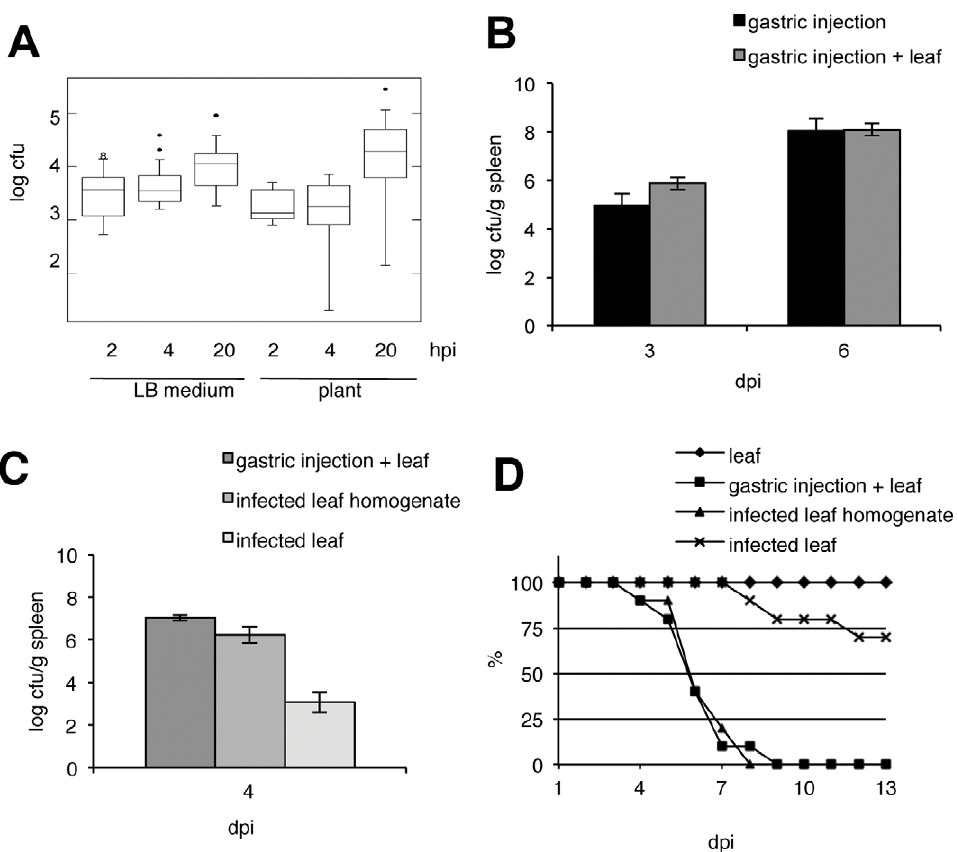
Figure 1. Plant-originated Salmonella retain their virulence toward animals. A ; Infection and proliferation of plant-grown S. Typhimurium in Caco-2 epithelial cells. Caco-2 cells were infected for 1 h with bacteria originating from LB medium or Arabidopsis (plant), then washed and incubated for an additional 2, 4 or 20 h in the presence of gentamicin. Bacteria were harvested from lysed epithelial cells. Bacterial colony forming unit (cfu) numbers were normalized to the multiplicity of infection (moi) number; number of bacteria used for infection divided by the number of epithelial cells. Variance analysis of cfu numbers was performed using the ANOVA F-test. No differences between plant and LB grown bacteria were found (p . 0.05). B–D ; Mice infection assays. C57BL/6 mice were infected with wild-type S. Typhimurium 14028 s. Systemic infection in spleens was verified 3 and 6 days post infection (dpi) ( B ) or 4 dpi ( C ). B ; Spleen infection in mice populations fed with Arabidopsis leaves (dark gray) is similar to infection in control population (black). C ; Systemic infection with plant-originated Salmonella . Mice were infected via gastric injection and fed with Arabidopsis leaves (dark grey), fed with an infected leaves homogenate (gray) or fed with whole infected leaf (light gray). D ; Survival of mice: fed with an infected Arabidopsis leaf (stars), fed with homogenate from infected leaves (triangles), infected with TSB-grown bacteria and fed with an Arabidopsis leaf (squares) or fed with non infected Arabidopsis leaf (diamonds). n=10 mice in each group, observations were carried out for 21 dpi.